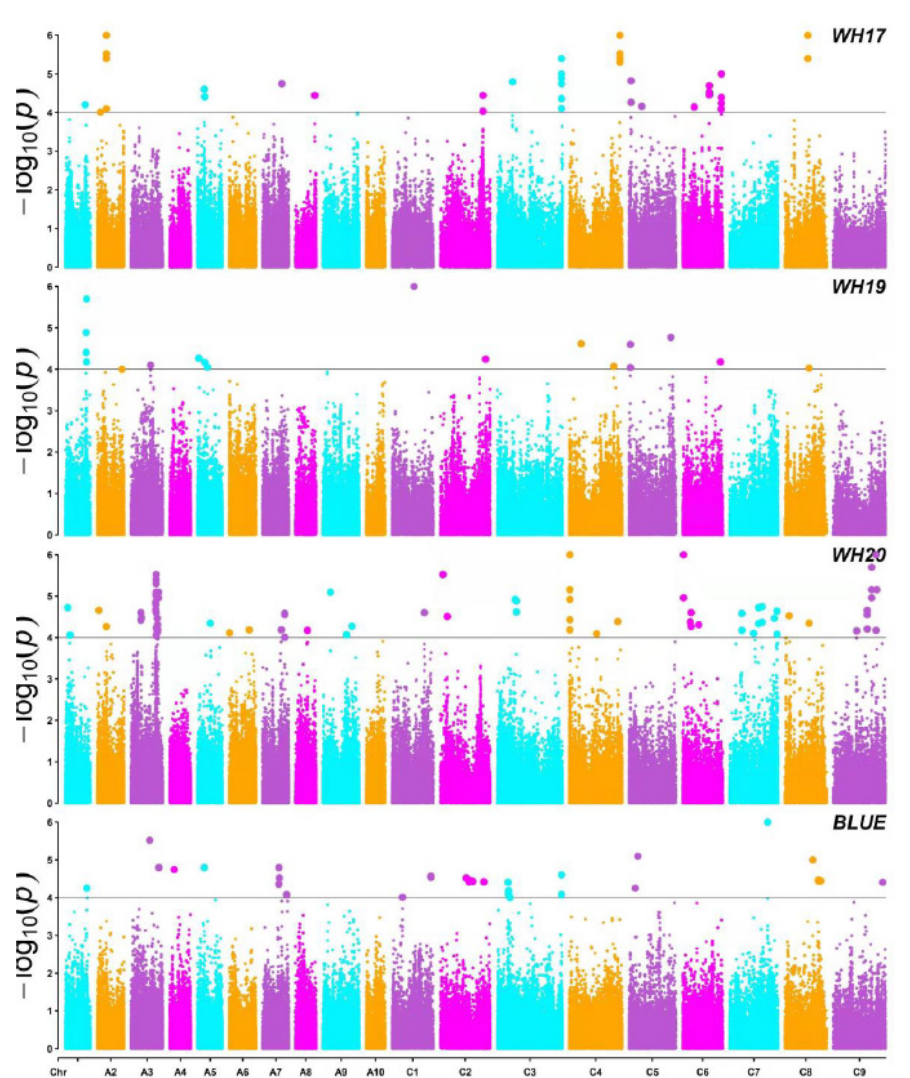
Figure 3. Manhattan plot of the phenotype-genotype association analysis for twelve root-related traits of B. napus by MLM in three environments and BLUE (WH17, WH19, WH20, and BLUE). The different colors in the plots indicate the 19 chromosomes from A01 to C09; the thick horizontal lines represent the threshold values ( − log 10 1/20,131 = 4.30 × 10 − 5 ) 4.30 × 10 − 5 . The color dots above the threshold values indicate the significant SNPs.